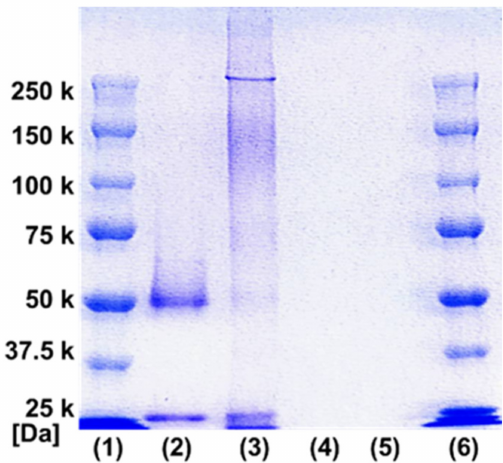
Figure 2. SDS-PAGE analysis results of the IgG–PNIPAAm conjugates: monomer concentration of IgG–PNIPAAm conjugates (lanes: (1) protein standard, (2) IgG, (3) 250 mM, (4) 400 mM, (5) 550 mM, (6) protein